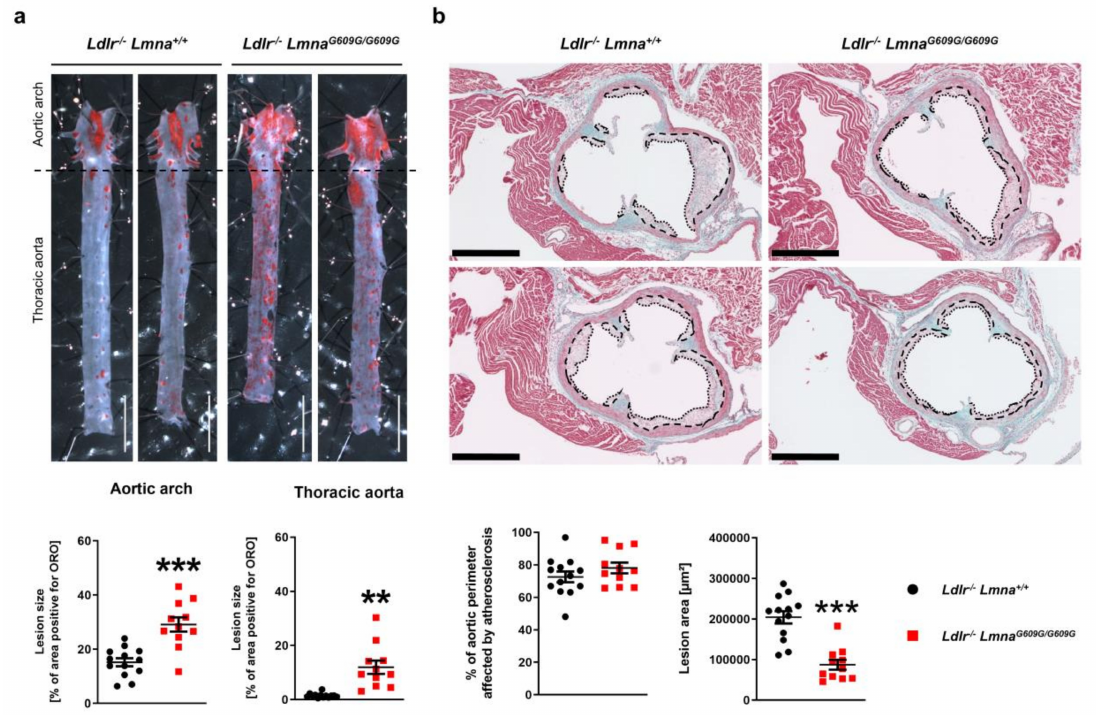
Figure A2. Female fat-fed Ldlr − / − Lmna G609G / G609G mice have an elevated atherosclerosis burden in the aortic arch and thoracic aorta and a higher percentage of the aortic perimeter a ff ected by atherosclerosis in the aortic root. Female mice were fed a high-fat diet from eight weeks of age and were sacrificed at 16 weeks of age. ( a ) Representative images of aortas stained with Oil Red O (ORO) and quantification of atherosclerosis burden (the percentage of the aortic surface positive for ORO) in the aortic arch and thoracic aorta of Ldlr − / − Lmna +/+ mice ( n = 13) and Ldlr − / − Lmna G609G / G609G mice ( n = 11). Scale bar, 5 mm. ( b ) Representative images of aortic root sections stained with Masson trichrome and quantification of plaque area and percentage of aortic perimeter a ff ected by atherosclerosis in Ldlr − / − Lmna +/+ mice ( n = 13) and Ldlr − / − Lmna G609G / G609G mice ( n = 11). Each point represents the mean for three aortic root regions per mouse (see Figure S3 for data analyzed for each region separately). Dashed lines indicate medial perimeter (the last layer of elastin), and dotted lines indicate the luminal surface of atheroma plaques. Scale bar, 500 µ m. Data are presented as mean ± SEM. Statistical analysis was performed by two-tailed t -test with Welch´s correction in ( a ) and by two-tailed t -test in ( b ). **, p < 0.01; ***, p <